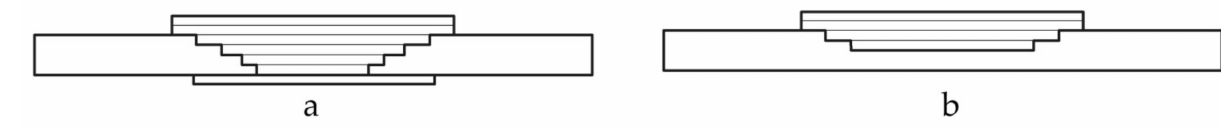
Figure 1. Pattern of installation of the composite repair patch for through defect ( a ) and partially through defect ( b